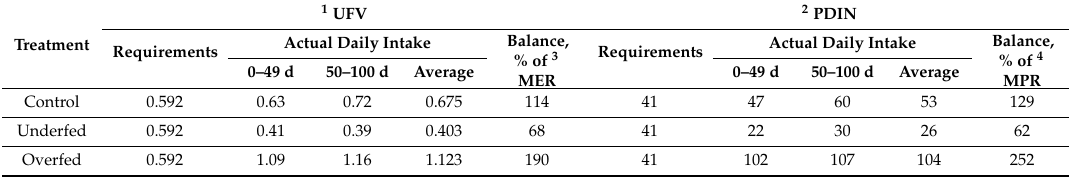
Table 3. Final average individual daily feeding balance, after calculating the average determined feed refusal per dietary treatment for each stage of the measurement period (i.e., challenge, from 0 to 49 days, and refeeding, from 50 to 100 days).